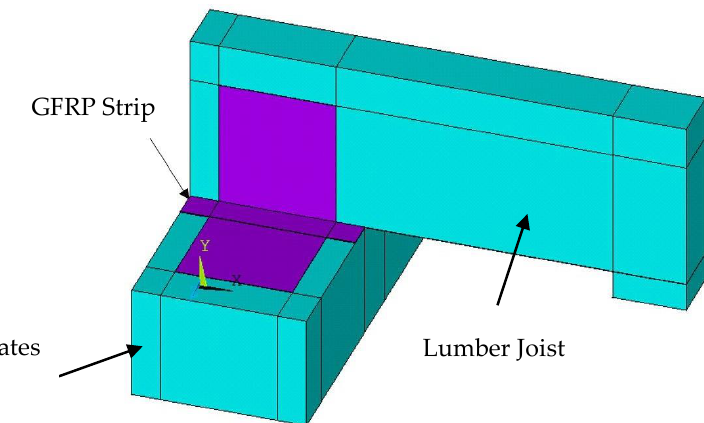
Figure 15. Anchored uplift model (TCLU-A). Table 5. Comparison of uplift test models with and without